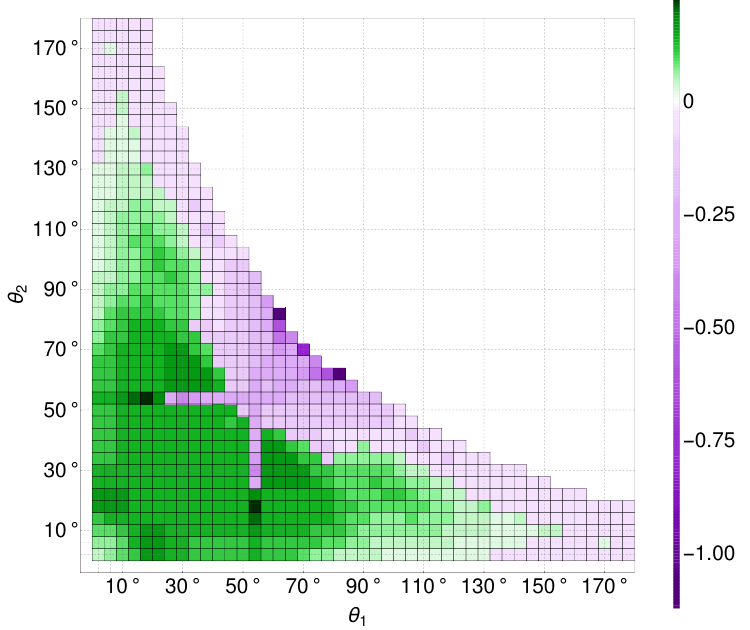
Figure 1: The distribution of ∆ SIGS for the deuteron breakup at E = 13